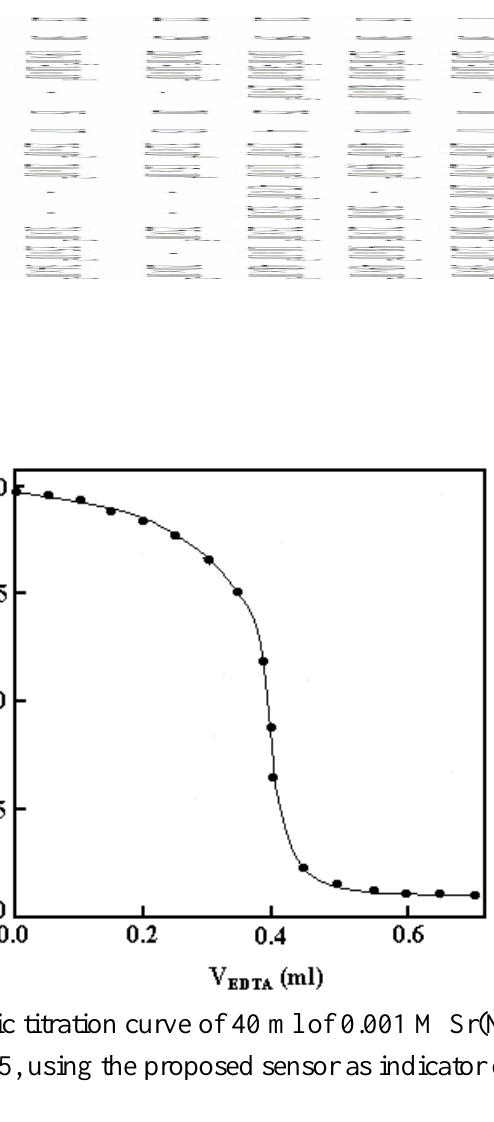
Table 3. Response characteristics and selectivity coefficients for different PVC-membrane Sr 2+ ion- selective electrodes.